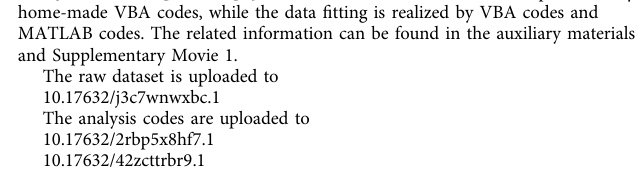
Fig. 24. We further used maximum power point (MPP) tracking for one MA 0.1 Cs 0.05 FA 0.85 PbI 3 -based device. The device main- tained 90% of the peak PCE value after 1800 h of